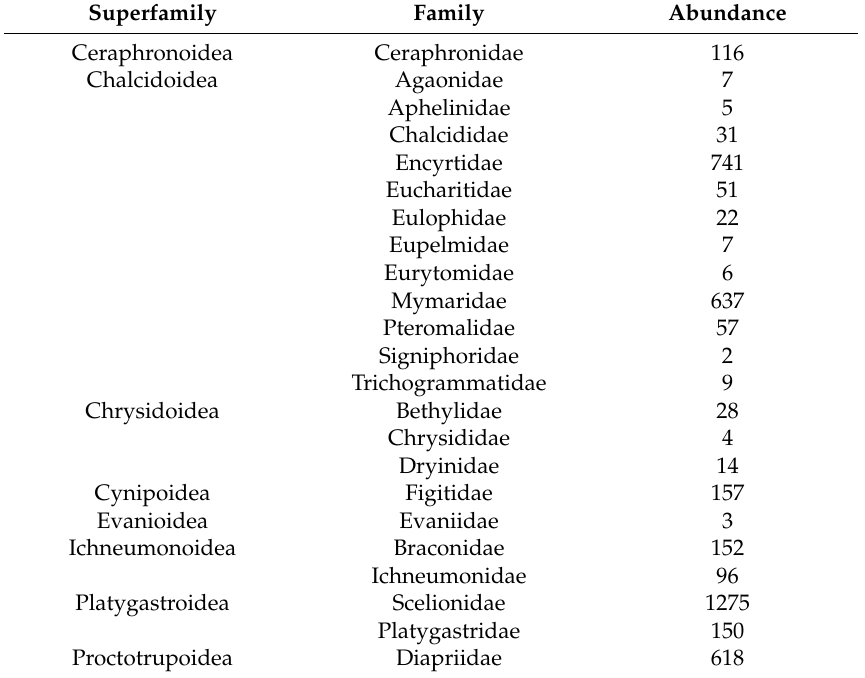
Table 2. Abundances of the families of parasitoid Hymenoptera collected in all samples.